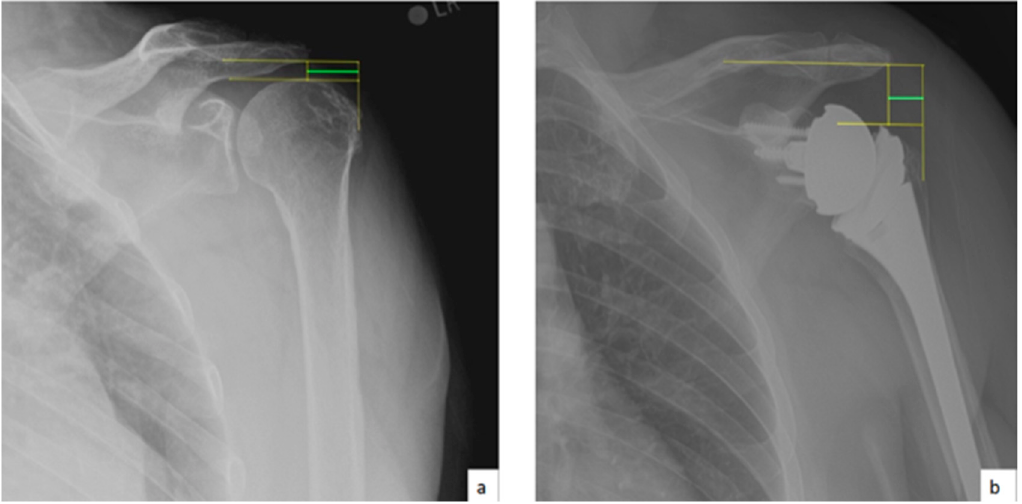
Figure 2. ( a ) Preoperative lateral humeral offset (LHO; green line); ( b ) postoperative lateral humeral offset (LHO; green line) .